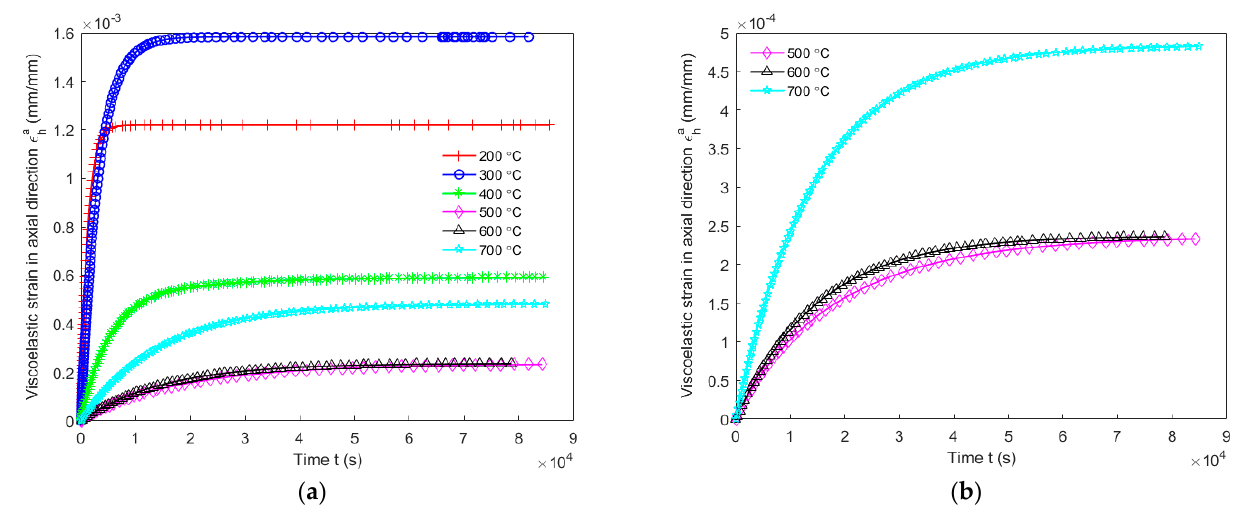
Figure 20. Modeling of viscoelastic strain of the carbon anode in the axial direction: ( a ) baking temperatures 200 °C–700 °C; ( b ) baking temperatures 500 °C, 600 and 700 °C.